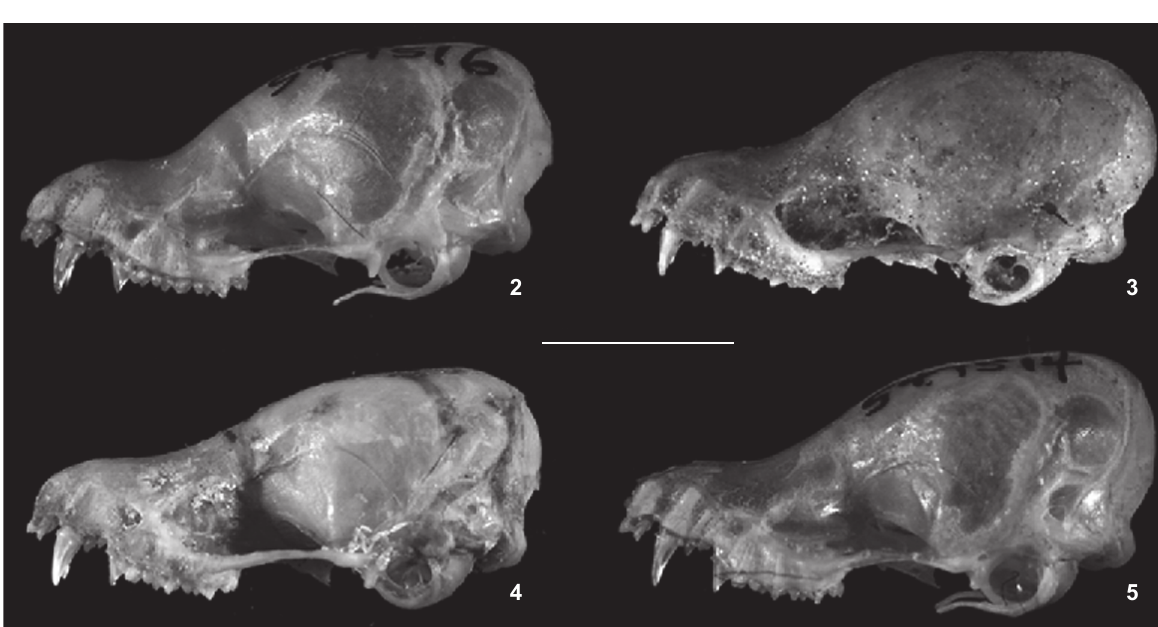
Figures 2-5. Lateral views of the skulls of Myotis albescens emphasizing differences in skull shape: (2) USNM 549516; (3) ALP 5165; (4) AMNH 77398; (5) USNM 549514. Scale bar: 5.0 mm.